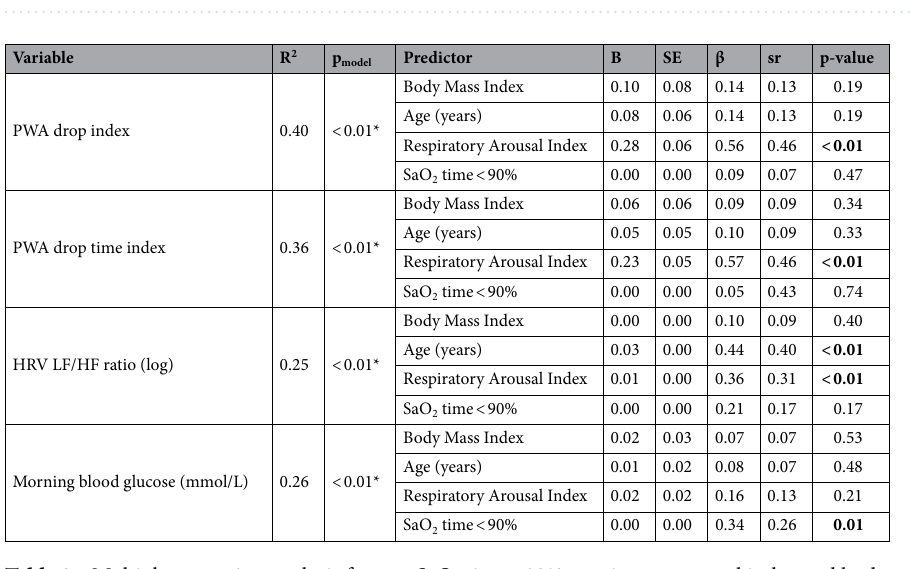
Table 3. Multiple regression analysis for age, SaO 2 time < 90%, respiratory arousal index and body mass index to predict nocturnal pulse wave amplitude, heart rate variability and morning blood glucose levels. *Significant model (p < 0.05) after false discovery rate adjustment; log logarithmic transformation, R 2 the models’ multiple correlations, B unstandardised regression coefficient, β standardised regression coefficient, PWA pulse wave amplitude, HRV heart rate variability, LF low frequency, HF high frequency, SaO 2 arterial blood oxygen saturation. Bolded p-values indicate statistically significant effects